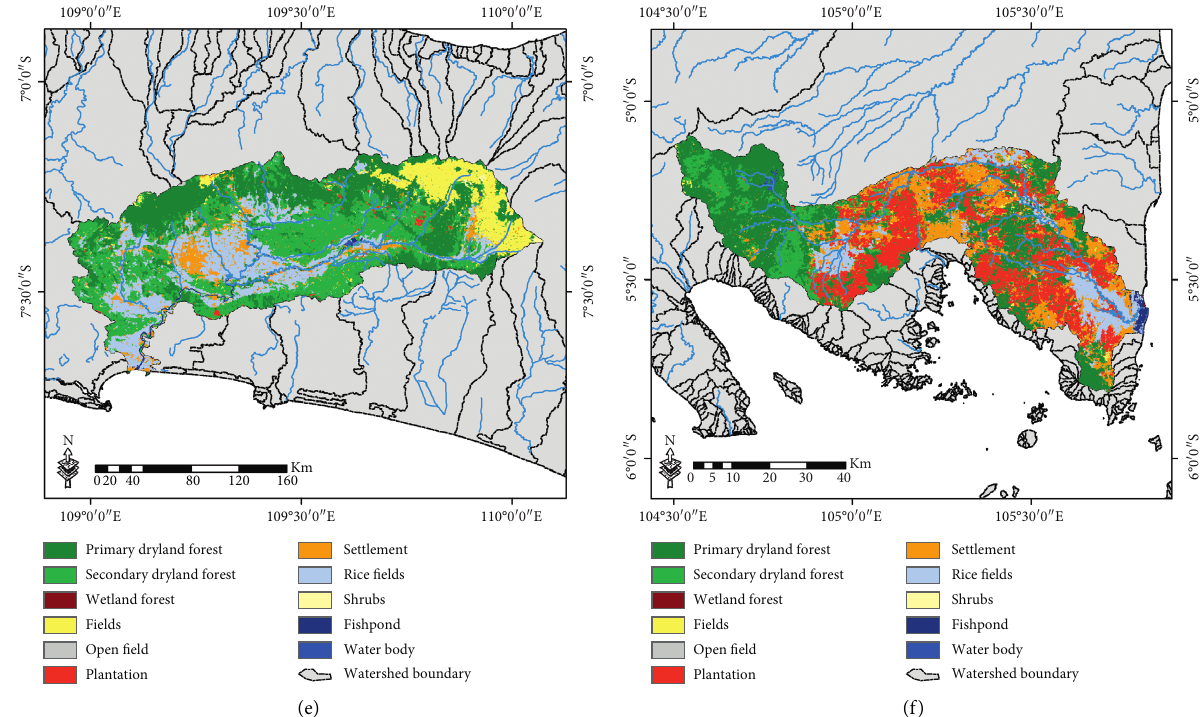
Figure 11: Results of the LULC classification based on the RF classifier: (a, d) Musi watershed; (b, e) Serayu watershed; (c, f) Sekampung watershed; process stage without the MaSegFil approach (a–c); process stage with the MaSegFil approach (d–f).